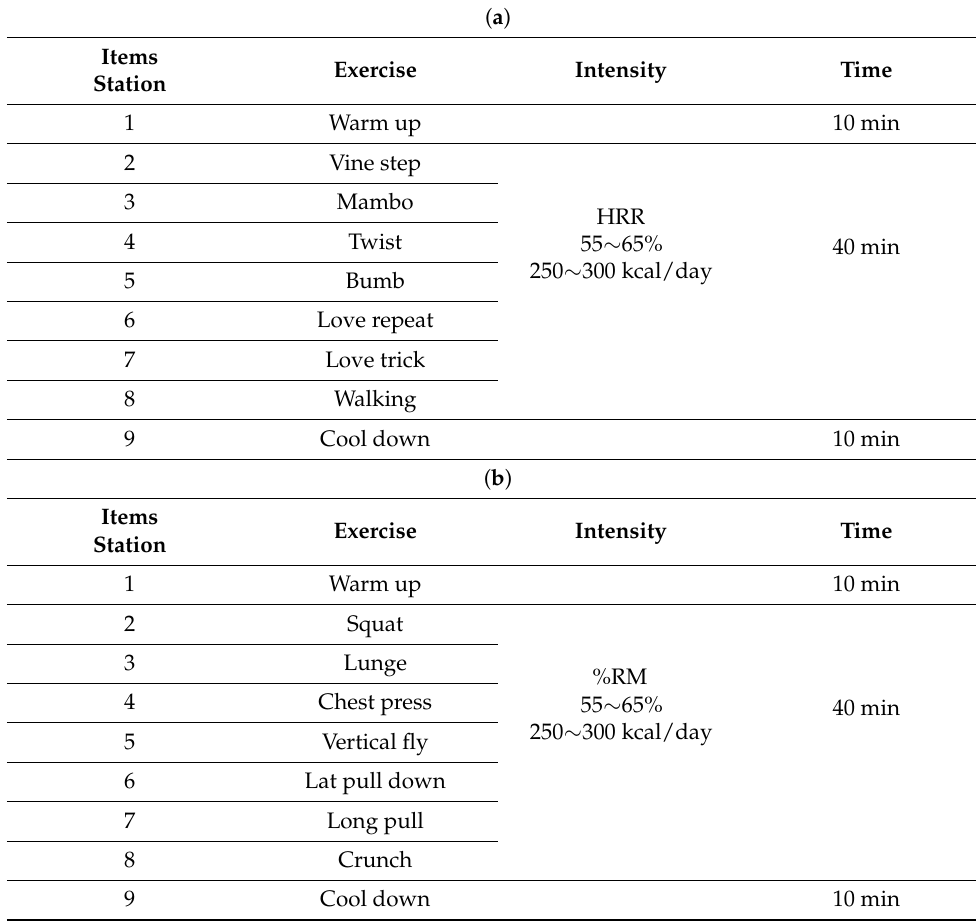
Table 2. ( a ) Aerobic physical activity. ( b ) Resistance physical